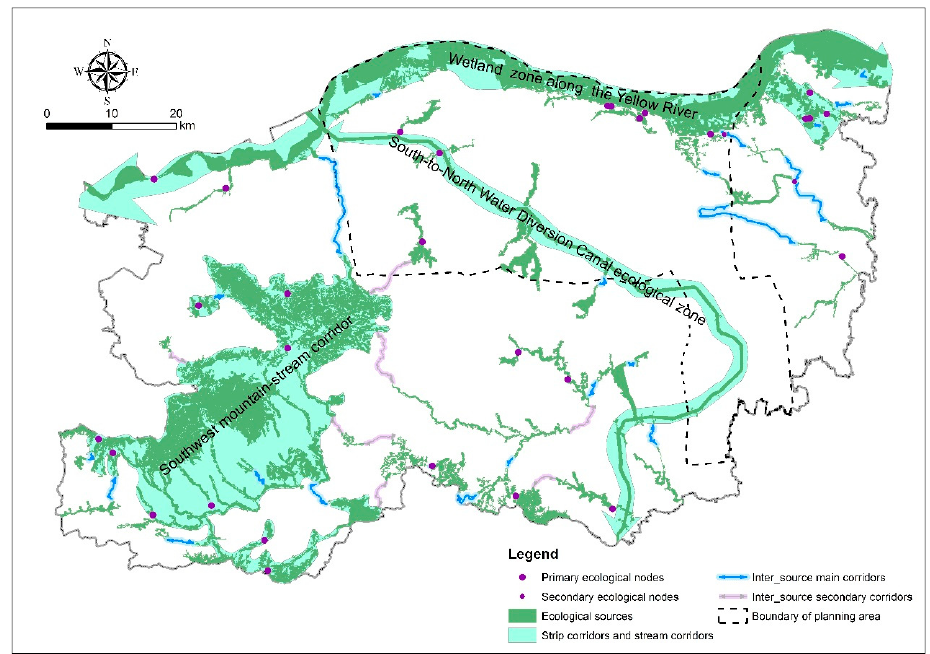
Figure 7. Distribution of the ecological corridors and ecological nodes.